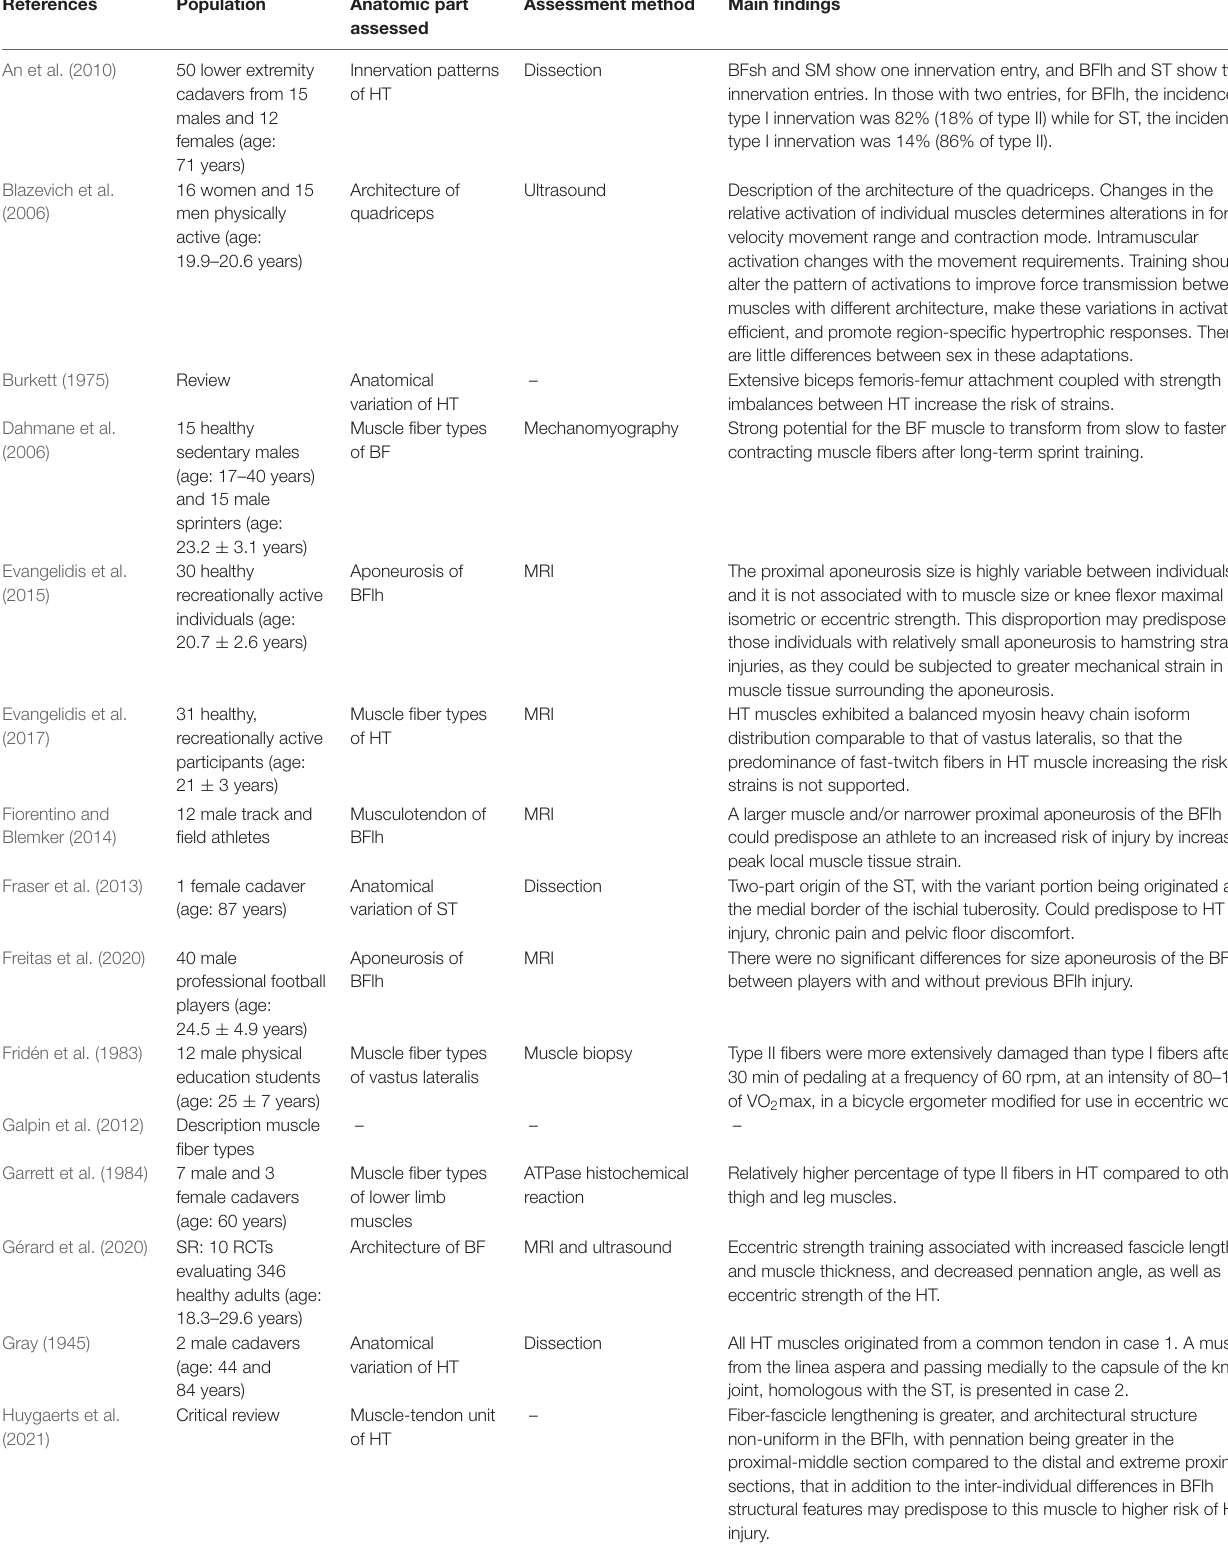
TABLE 1 | Summary of studies cited in Section “Anatomic and Physiologic Variations of the